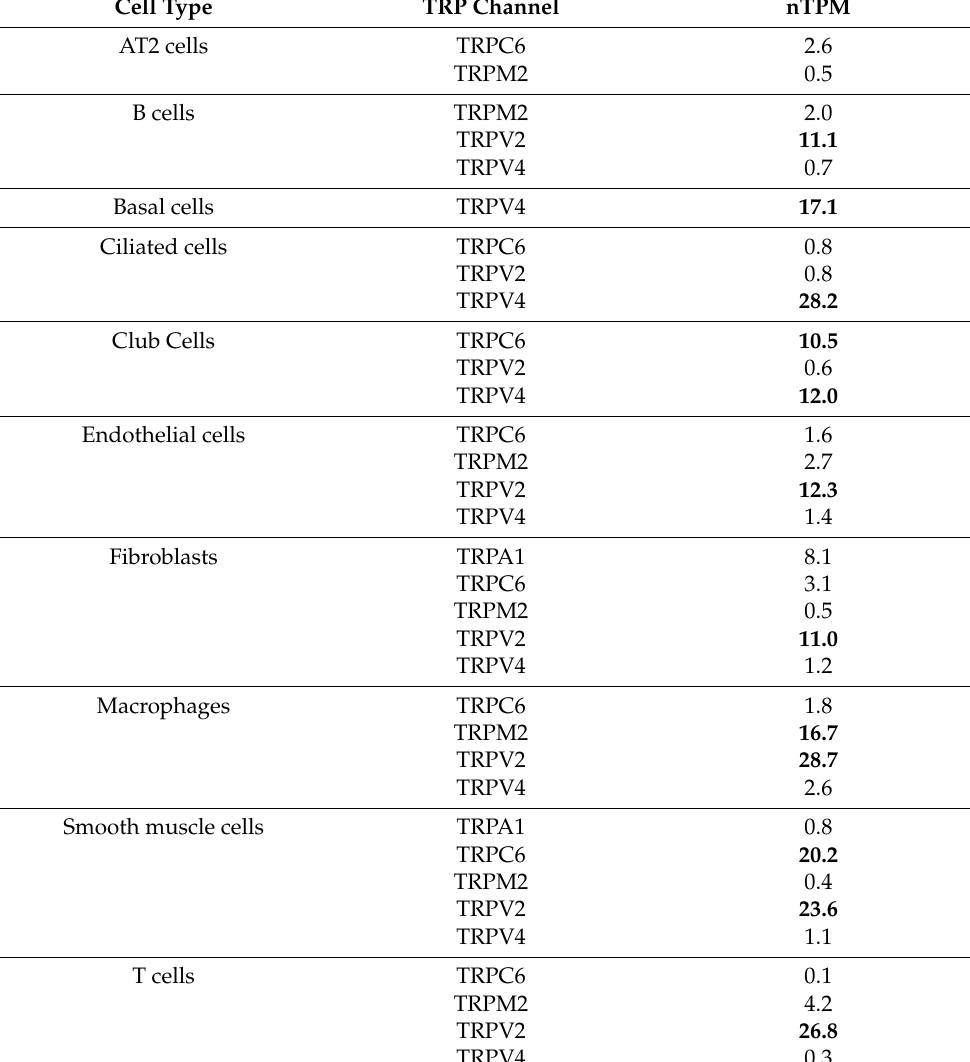
Table 1. Single-cell mRNA expression levels of TRP channels in the respiratory